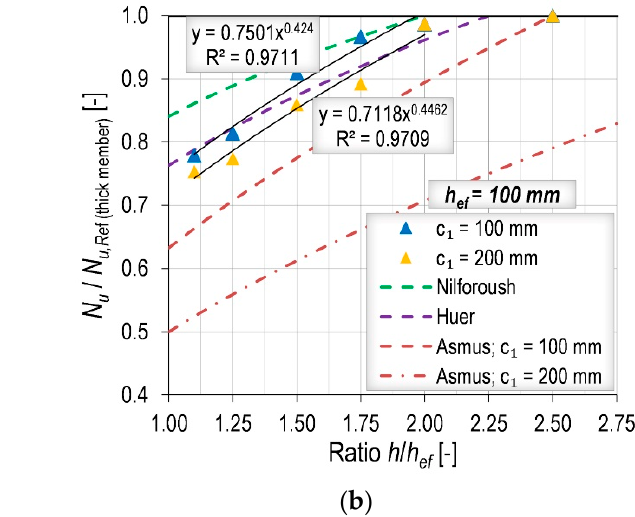
Figure 6. Influence of member thickness: ( a ) relative capacities for different embedment depths; ( b ) relative capacities compared to the existing design models in the literature.